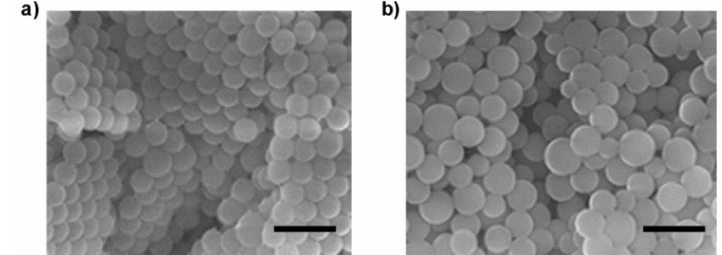
Figure 4. SEM images of the Mal-decorated polymer particles obtained by dispersion copolymerization employing ( a ) P3 and ( b ) P4 of MA-PIBVE- b -P(VE-Mal). Bars: 1 µ